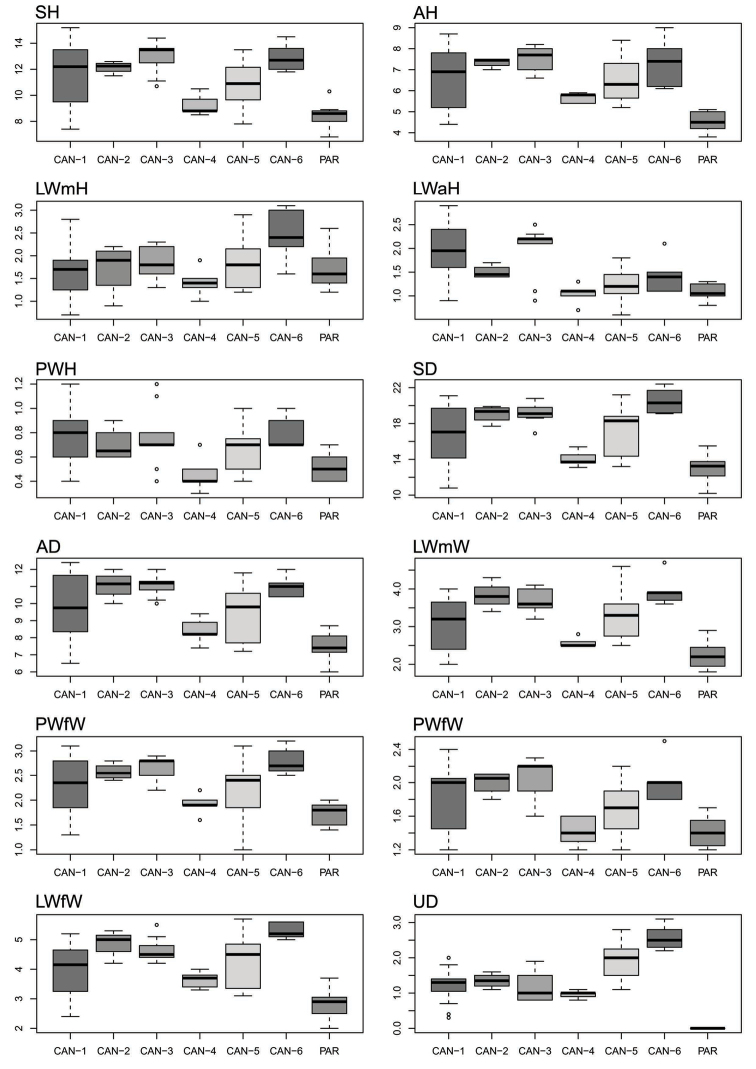
Box plots for shell characters of the seven Monacha clades investigated. The lower and upper limits of the rectangular boxes indicate the 25th to 75th percentile range, and the horizontal line within the boxes is the median (50th percentile).